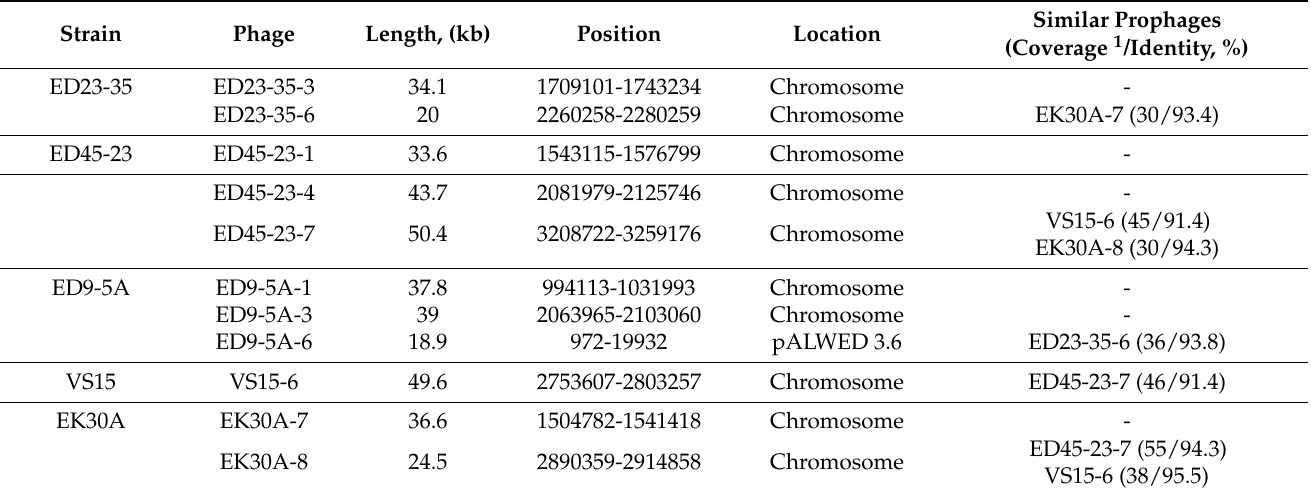
Table 8. Intact prophages identified in the genomes of permafrost strains of A. lwoffii